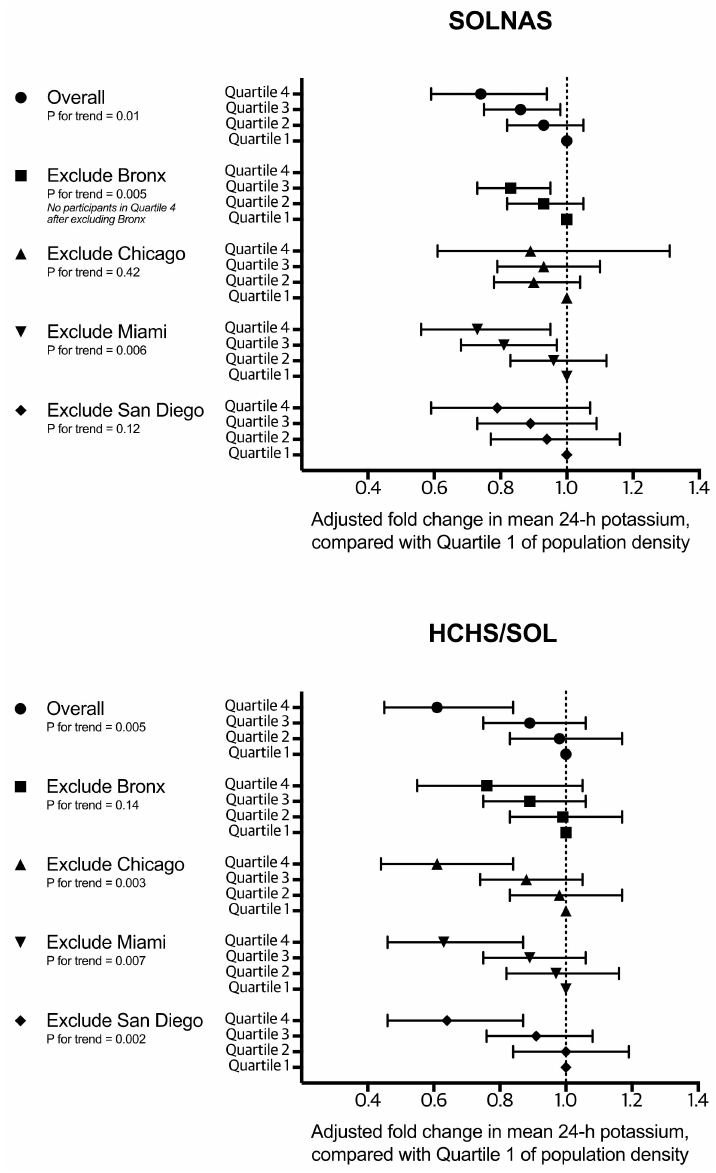
Figure 2. Adjusted fold change in the mean of 24-h potassium intake by quartiles of neighborhood population density, SOLNAS and HCHS/SOL, when leaving out each of the four study sites to better understand individual site influence on the overall